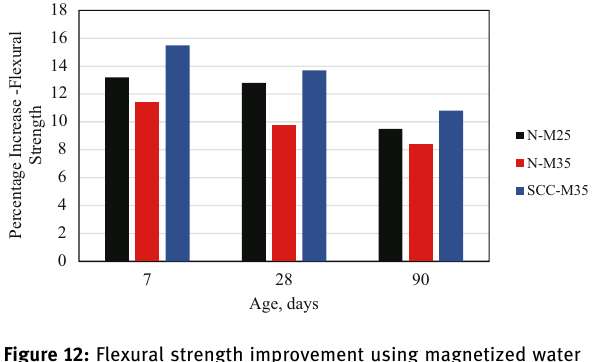
Figure 12: Flexural strength improvement using magnetized water instead of tap water for all